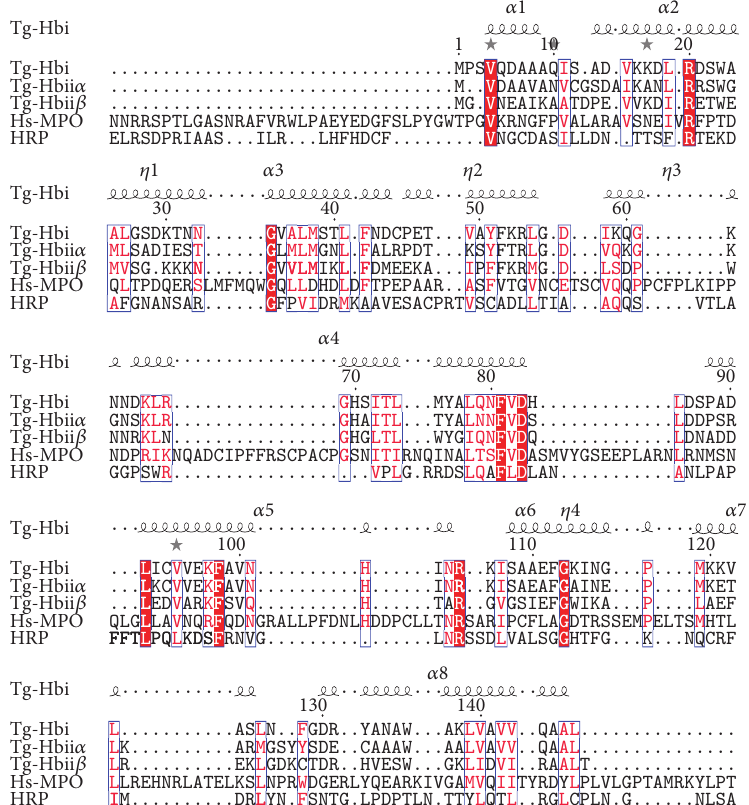
Figure 6: Amino acid sequence alignment of four proteins. Same amino acid residues are shaded in red, similar amino acids are shaded in box, and 𝛼 -helices are shown as 𝛼 1 to 𝛼